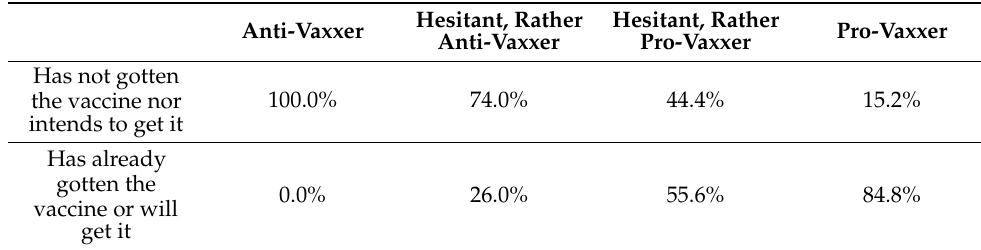
Table A3. Crosstabulation of the attitude towards the Piresian vaccine with the traditional objective measurement of vaccine hesitancy. Column percentages.